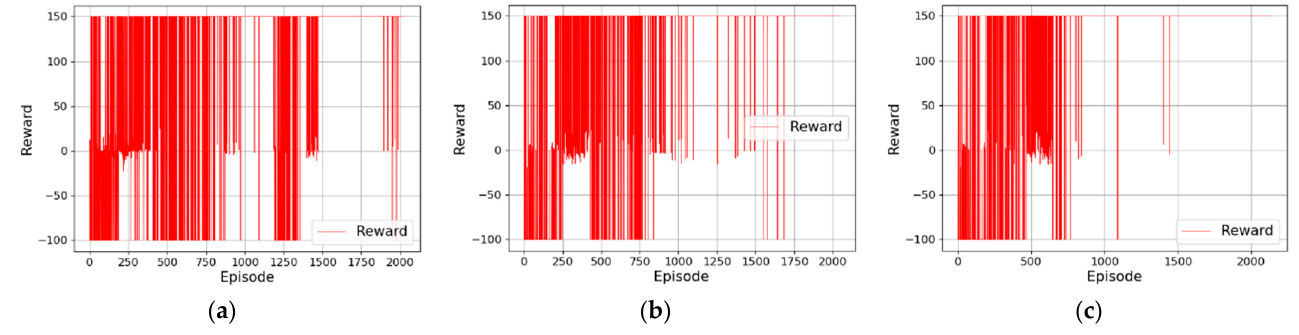
Figure 7. Changes in reward value of the improved algorithms. ( a ) Changes in reward value of the algorithm proposed in [31]; ( b ) changes in reward value of LSTM-DDPG, ( c ) changes in reward value of MN-LSTM-DDPG. of MN-LSTM-DDPG.